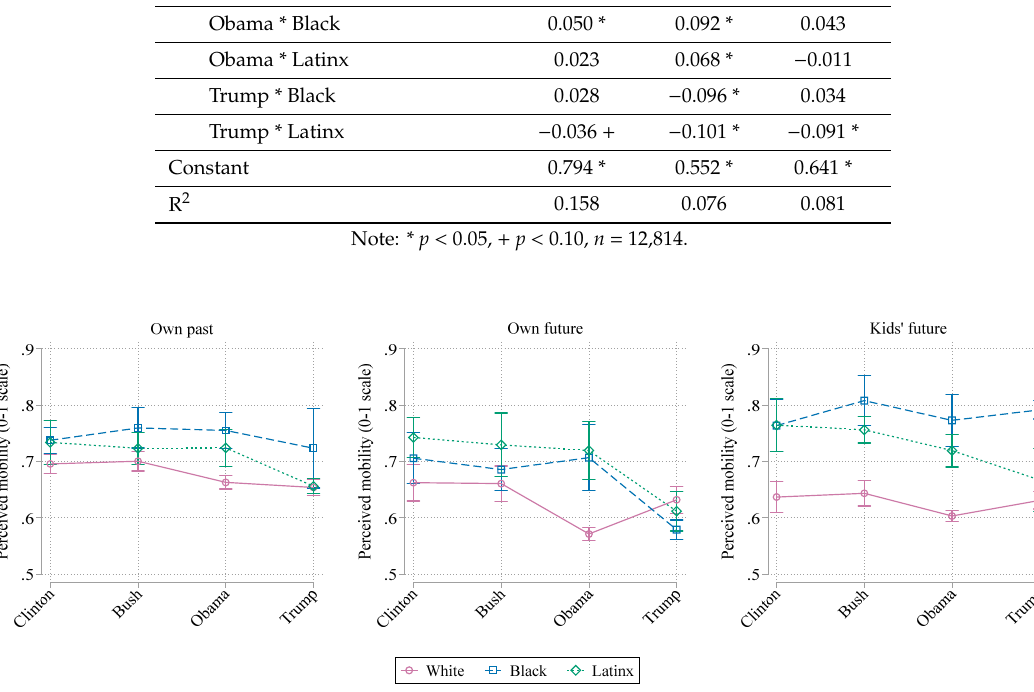
Figure 2. Perceived mobility, by presidential administration and race (adjusted for socioeconomic and demographic controls). Confidence intervals are at the 95% level. Predictive margins are based on models in Table 2.